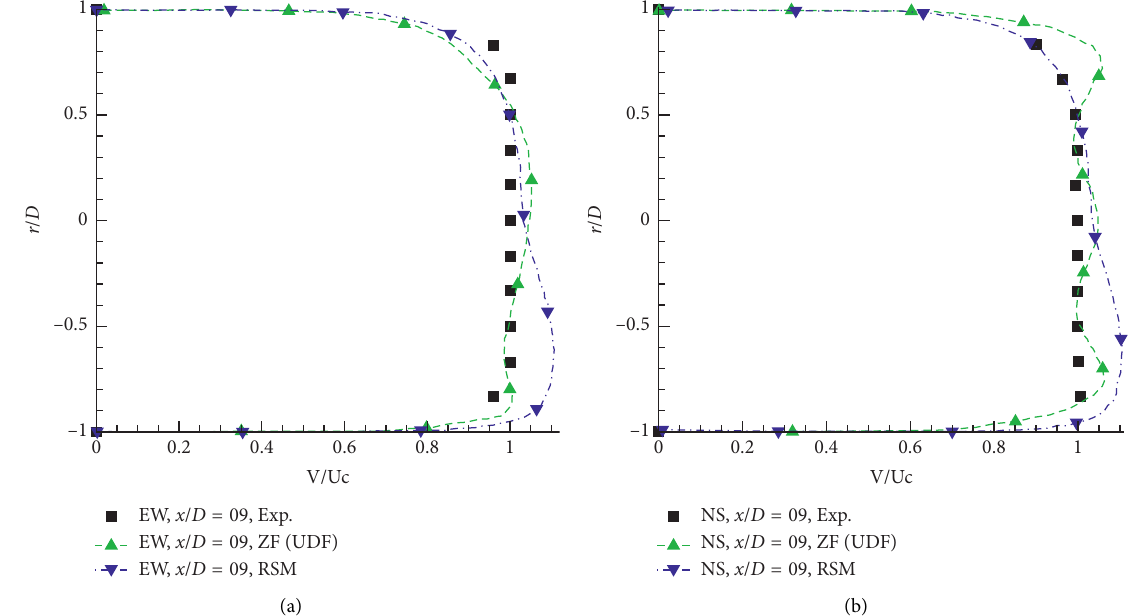
Figure 8: Normalized velocity profiles for different turbulence models at x / D � 9.